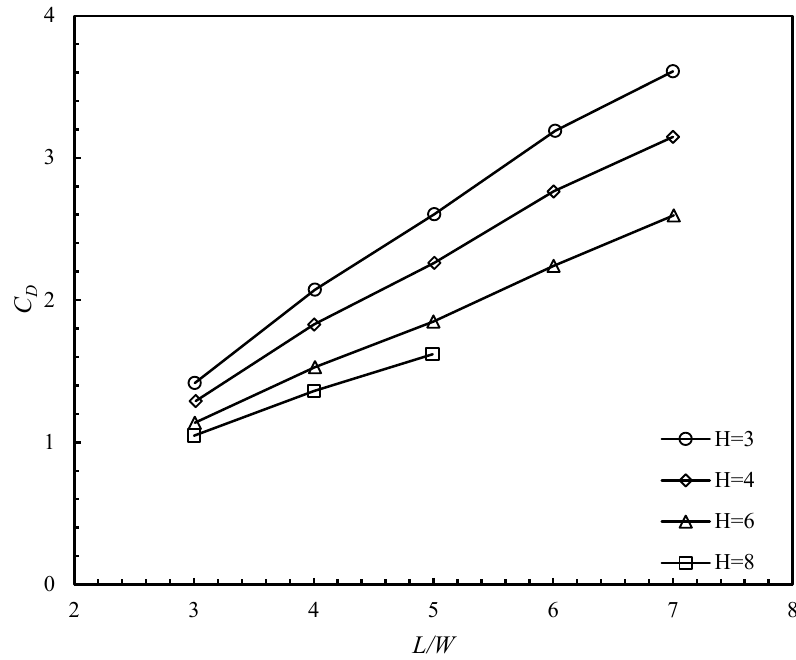
Figure 6. Variation of C D with L/W ratio.